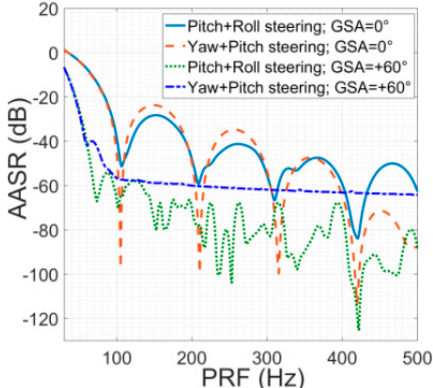
Figure 15. AASR of Geo-SAR in different attitude steering method conditions at a latitude argument of 23.4°.